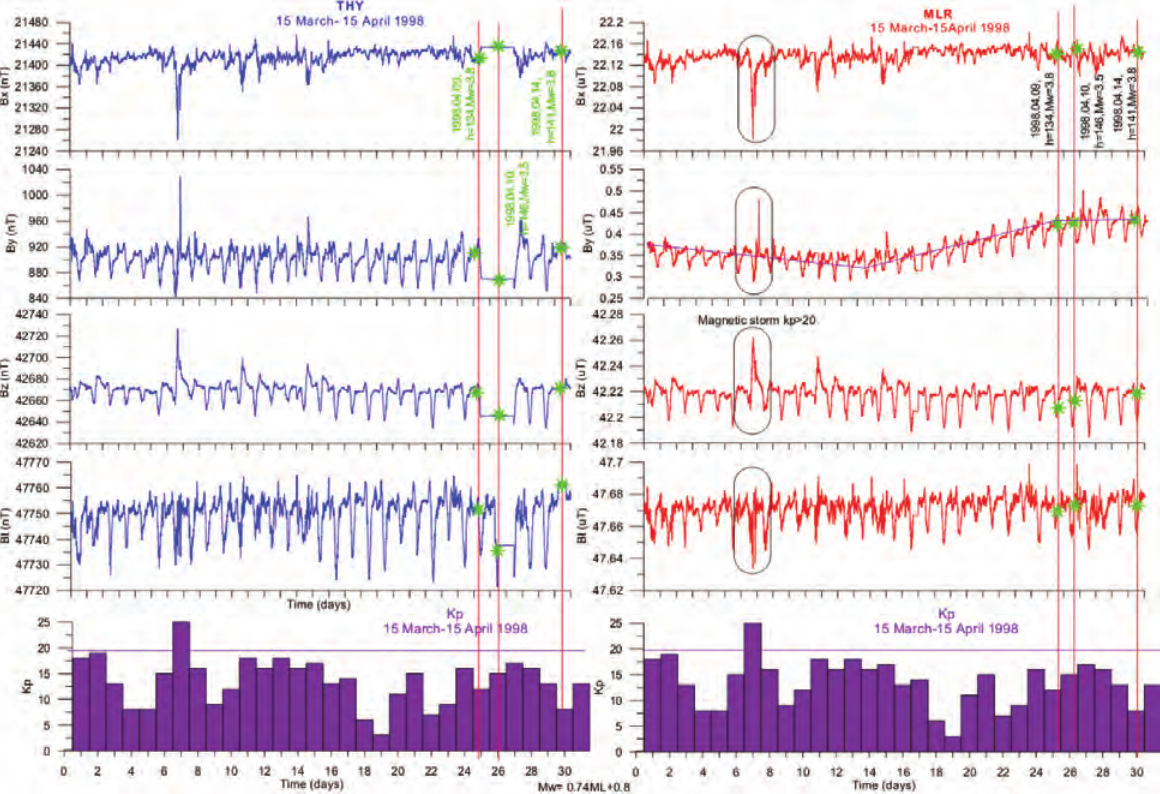
Figure 5. On March 21, 1998 (day 7) another magnetic storm ( Kp = 25) induced a variation in the geomagnetic flux density. It can be seen that the By component has a V-shaped anomaly, which ends on day 25 (April 9, 1998). Two earthquakes ( Mw = 3.8 h = 134 km, and Mw = 3.5 h = 146 km, respectively) occurred on April 9, 10,